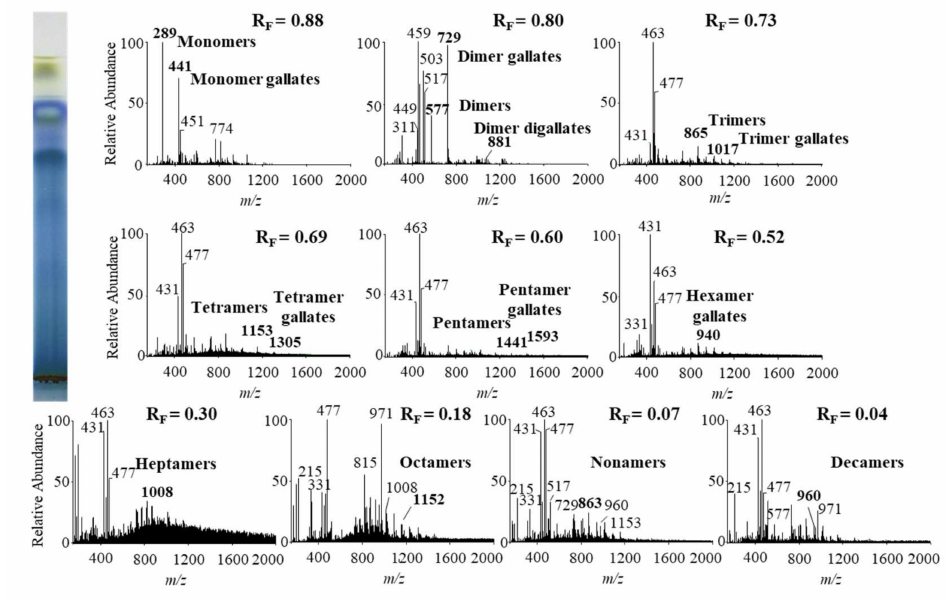
Figure 10. MS spectra obtained by HPTLC–MS analysis of STS from giant knotweed leaves on HPTLC diol F 254S plate pre-developed and developed with acetonitrile. The bolded m / z values in the MS spectra belong to B-type proanthocyanidins and their gallates, which were eluted from the plate with acetonitrile–methanol (2:1, v / v ). A part of the plate was derivatized with DMACA